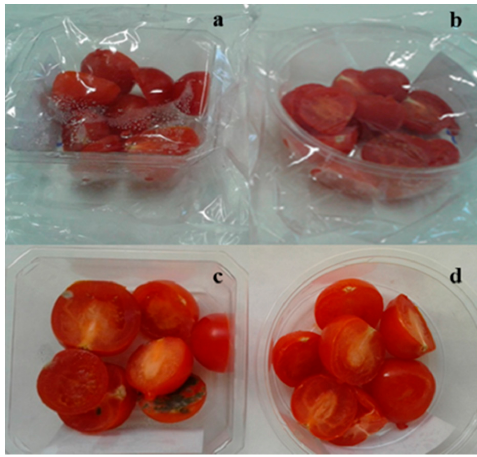
Figure 5. Cherry tomatoes packed in ( a , c ) non-biodegradable PP Coex/PET and ( b , d ) compostable